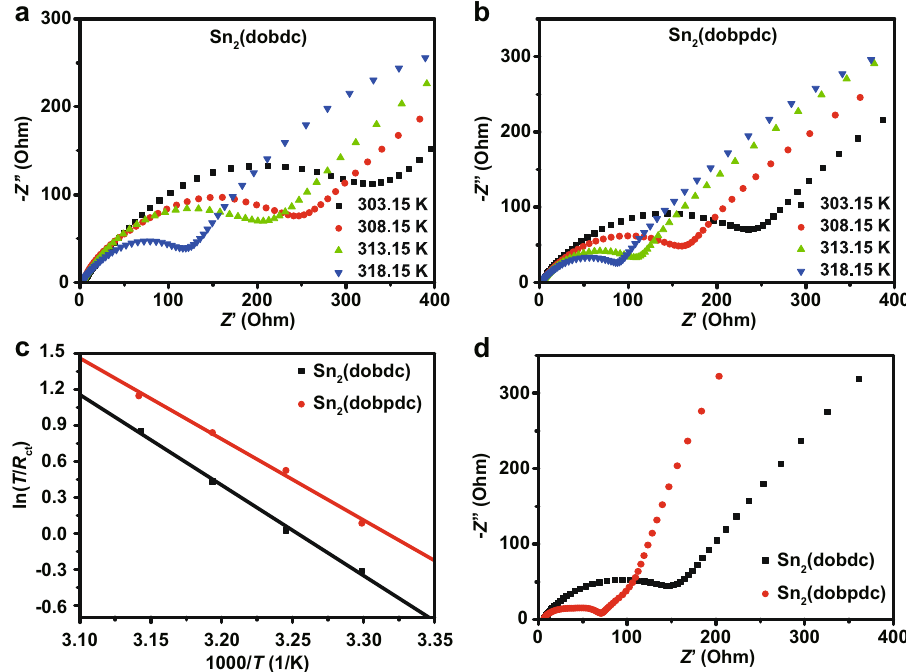
Fig. 3 Kinetic analysis of Sn 2 (dobdc) and Sn 2 (dobpdc). a , b EIS of Sn 2 (dobdc) and Sn 2 (dobpdc). c Plots of ln( T / R ct ) and 1000/T for Sn 2 (dobdc) and Sn 2 (dobpdc). d EIS of the two Sn-MOF electrodes after 200 cycles.